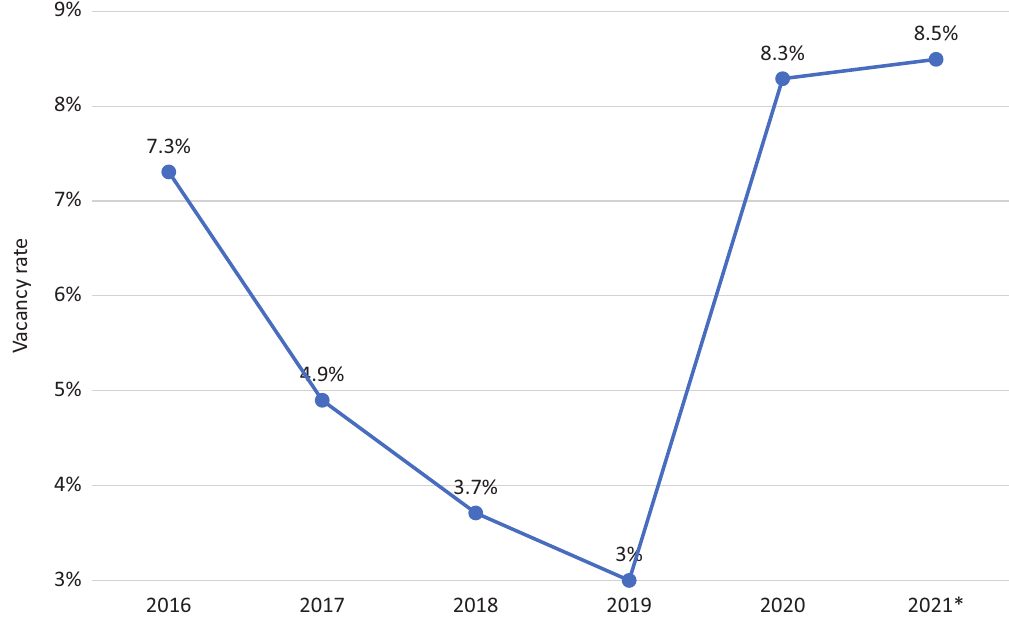
of 2021 and 9% by July that year. The latter shows the drastic impact of the Covid‐19 lockdowns and the con‐ tinued shift of economic activity away from the Sydney CBD during 2021.